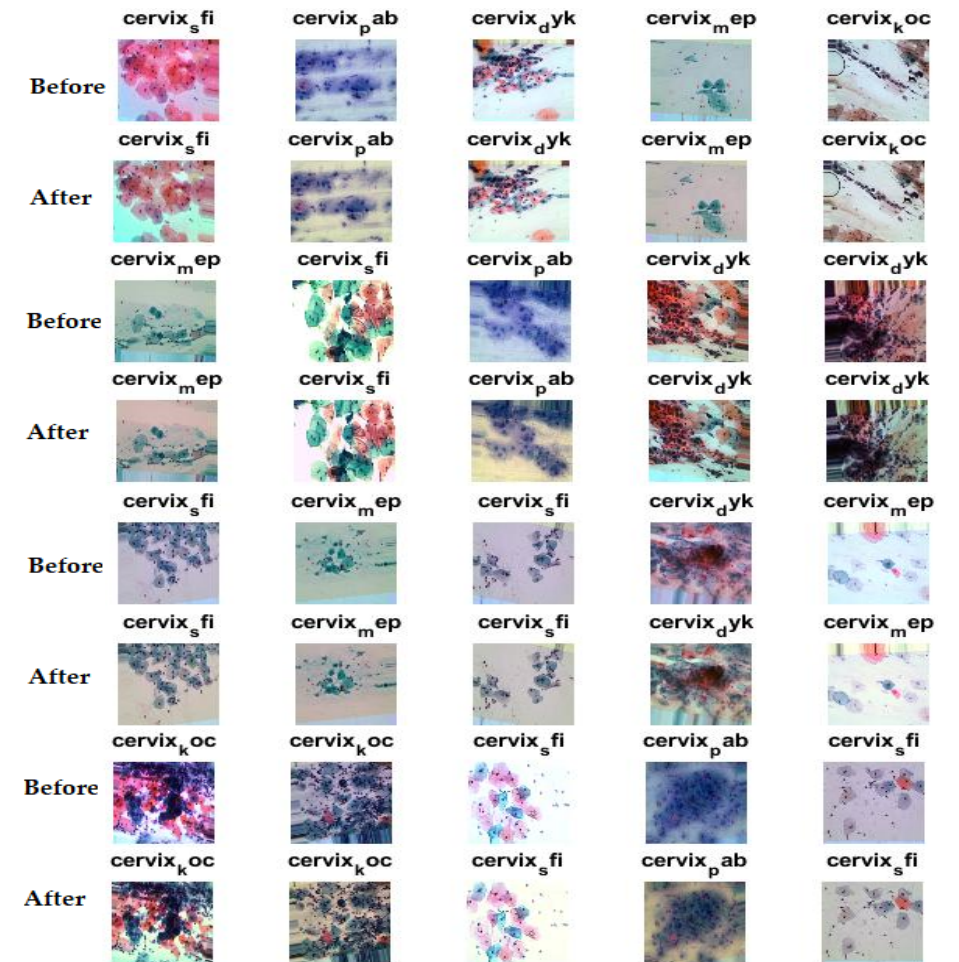
Figure 2. Samples of the abnormal cells of cervical malignancies before and after enhancement.